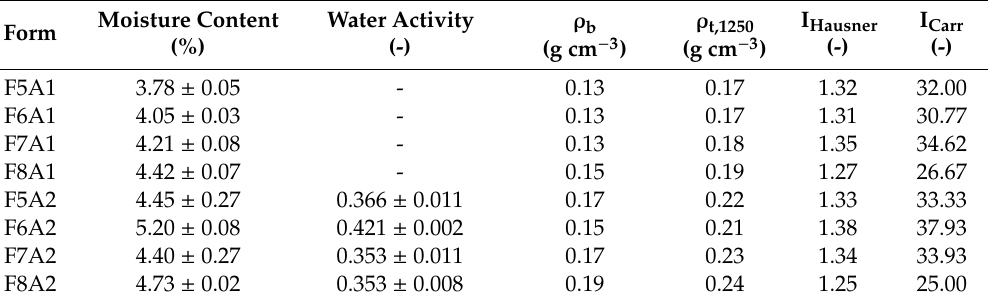
Table 3. Properties of the spray-dried